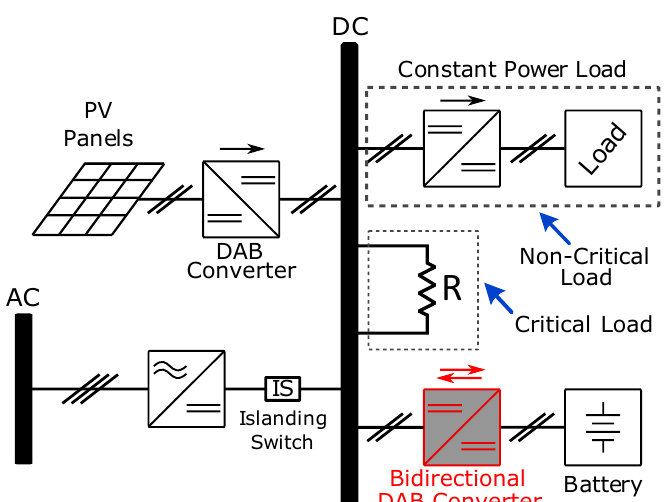
Figure 4. Simplified dc microgrid with a battery energy storage